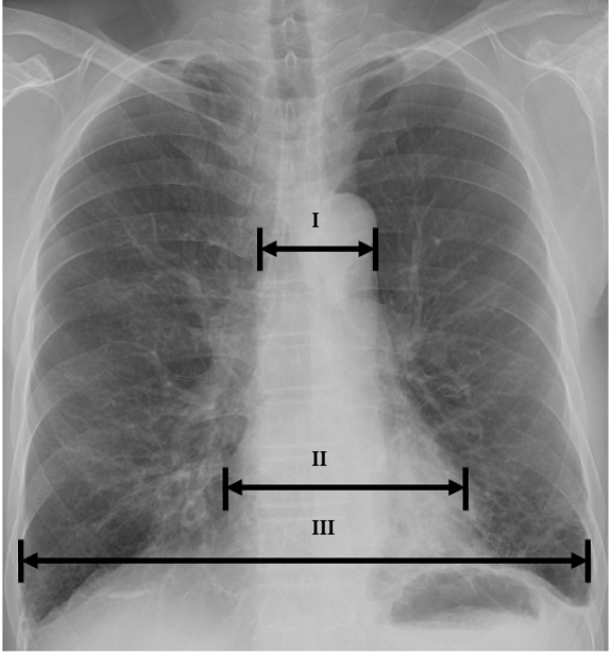
Figure 2. Calculation of radiologic parameters on simple chest radiography. Cardio-thoracic ratio = II/III; mediastinal-thoracic ratio = I/III; mediastinal-cardiac ratio = I/II; I = mediastinum width; II = maximal transverse diameter of heart; III = maximal transverse diameter of chest.